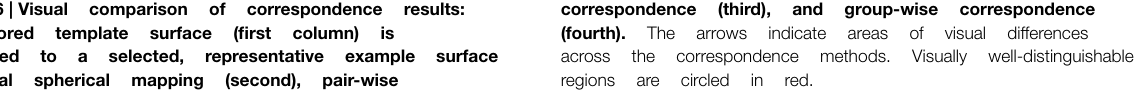
correspondence (third), and group-wise correspondence (fourth). The arrows indicate areas of visual differences across the correspondence methods. Visually well-distinguishable regions are circled in